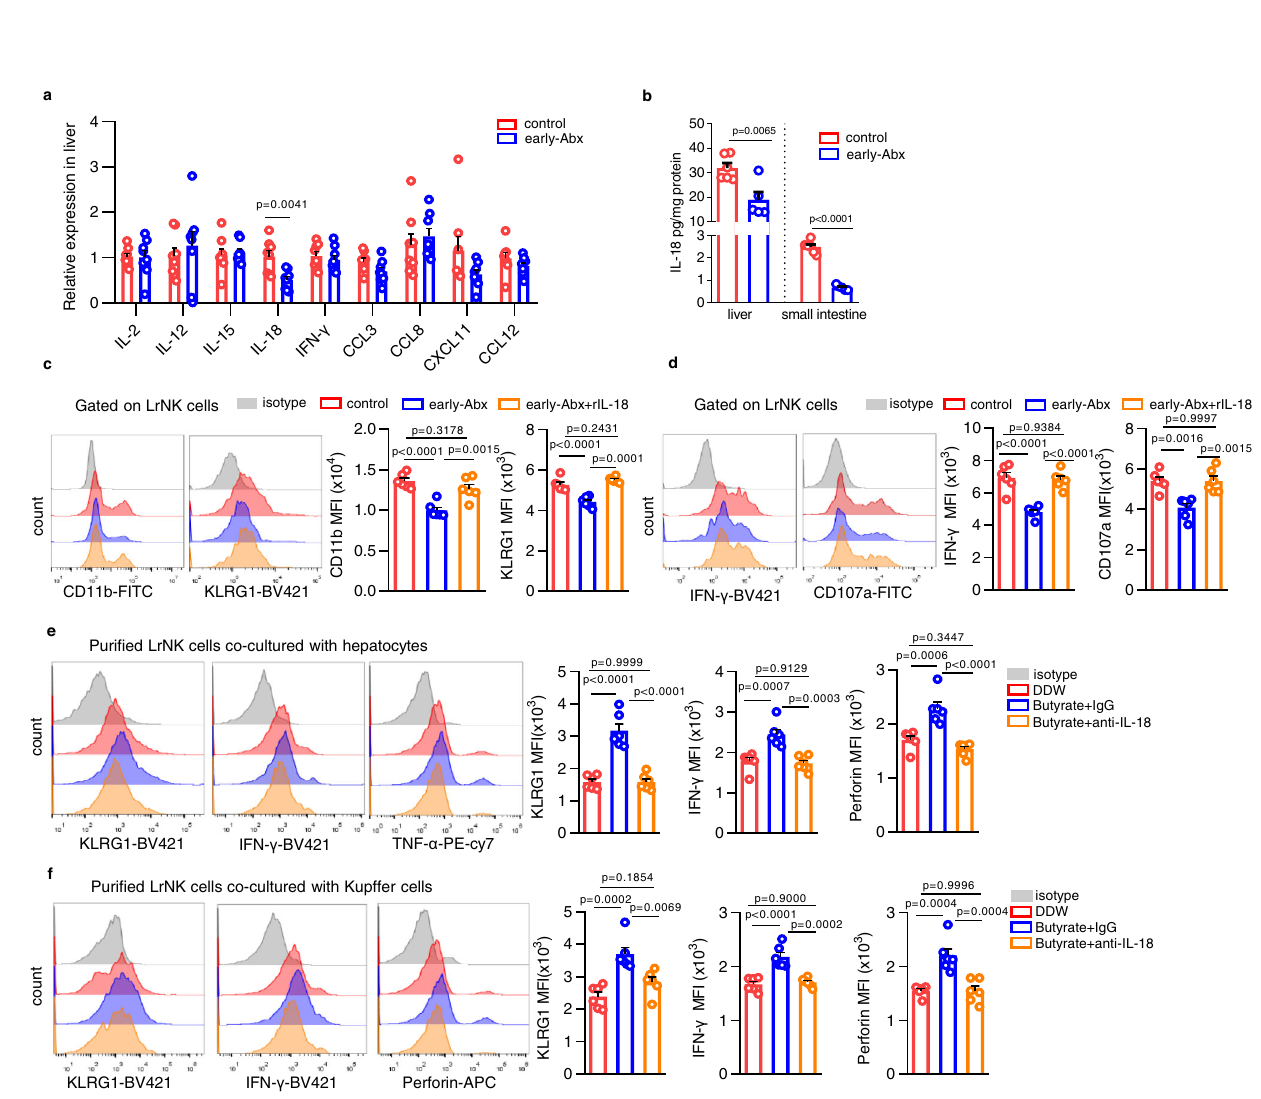
Fig. 6 | Butyrate triggers IL-18 production in hepatocytes / Kupffer cells to improve functional maturation of LrNK cells. a RT-qPCR analysis of indicated cytokines/chemokines expression level in liver tissues from control or early-Abx mice( n =8pergroup). b ELISAassayforIL-18levelsinliversandsmallintestinesof control ( n =6 per group) and early-Abx ( n =5 per group) mice. c , d Representative FACS plots and bar graph for the expression (MFI) of maturation markers or effector molecules in LrNK cells from control or early-Abx mice with or without recombinant IL-18 treatment ( n =6 per group). e , f Representative FACS plots and